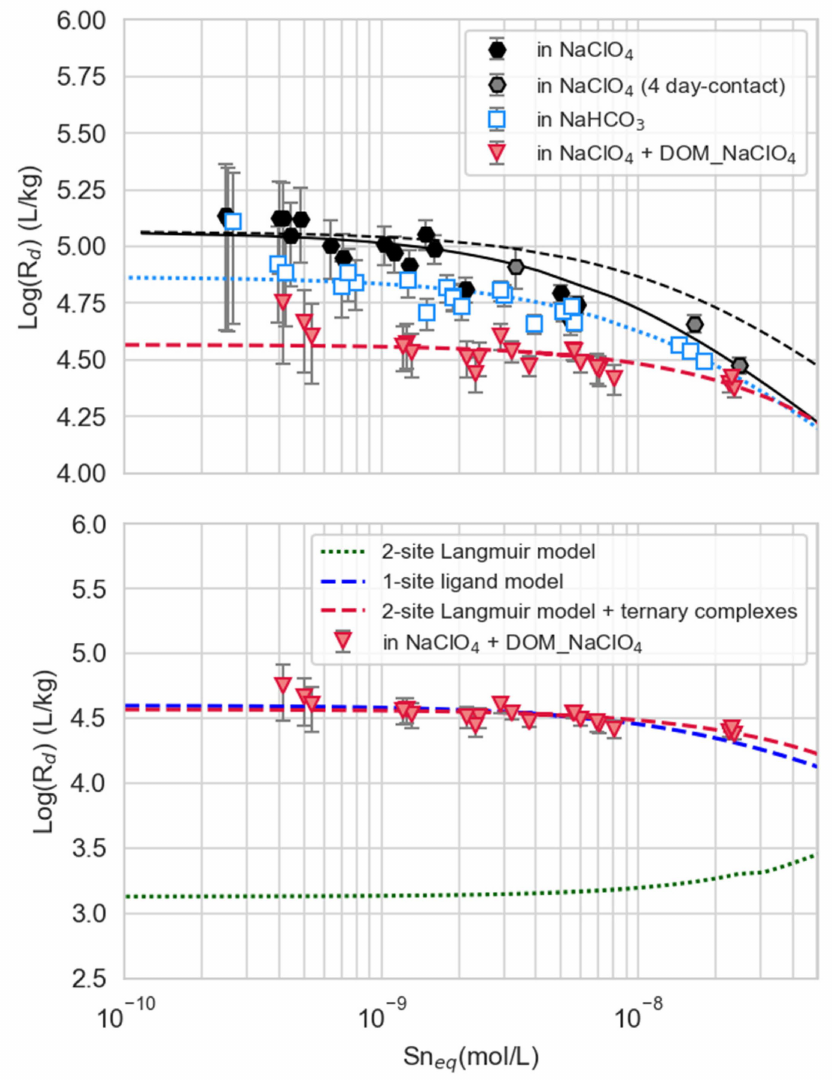
Figure 2. Up: Sorption isotherms of Sn(IV) on IdP in 0.017 M NaClO 4 , 0.015 M NaHCO 3 and 0.017 M NaClO 4 + 4.5 ppmC DOM_NaClO 4 . Markers = experimental points, black dotted line = 2SPNE SC model ( log K 3 = 9.1 and log K 4 = 0.6), black solid line = 2SPNE SC model ( log K 3 , log K 4 (Table 5), ≡ S s OH (Table 3)), blue dotted line = 2SPNE SC model ( log K ≡ S s OH (Table 3)) + 3 , log K 4 (Table 5), Sn(IV)-carbonate complexation (log K 5 ), red dashed line = 2SPNE SC model ( log K 3 , log K 4 Table 5), ≡ S s OH (Table 3)) + Sn(IV)-DOM complexation ( log K s**(Sn-DOM) , log K w**(Sn-DOM) (Table 5)) + Clay- Sn(IV)-DOM complexation ( log K 7/8 (Table 5)). Bottom: Sorption isotherms of Sn(IV) on IdP in 0.017 M NaClO 4 + 4.5 ppmC DOM_NaClO 4 . Green dotted line = 2SPNE SC model ( log K 3 , log K 4 (Table 5), ≡ S s OH (Table 3)) + + Sn(IV)-DOM complexation (log K s**(Sn-DOM) , log K w**(Sn-DOM) (Table 5)), dark blue dashed line = 2SPNE SC model ( log K 3 , log K 4 (Table 5), ≡ S s OH (Table 3)) + Sn(IV)-DOM complexation ( log K 6 (Table